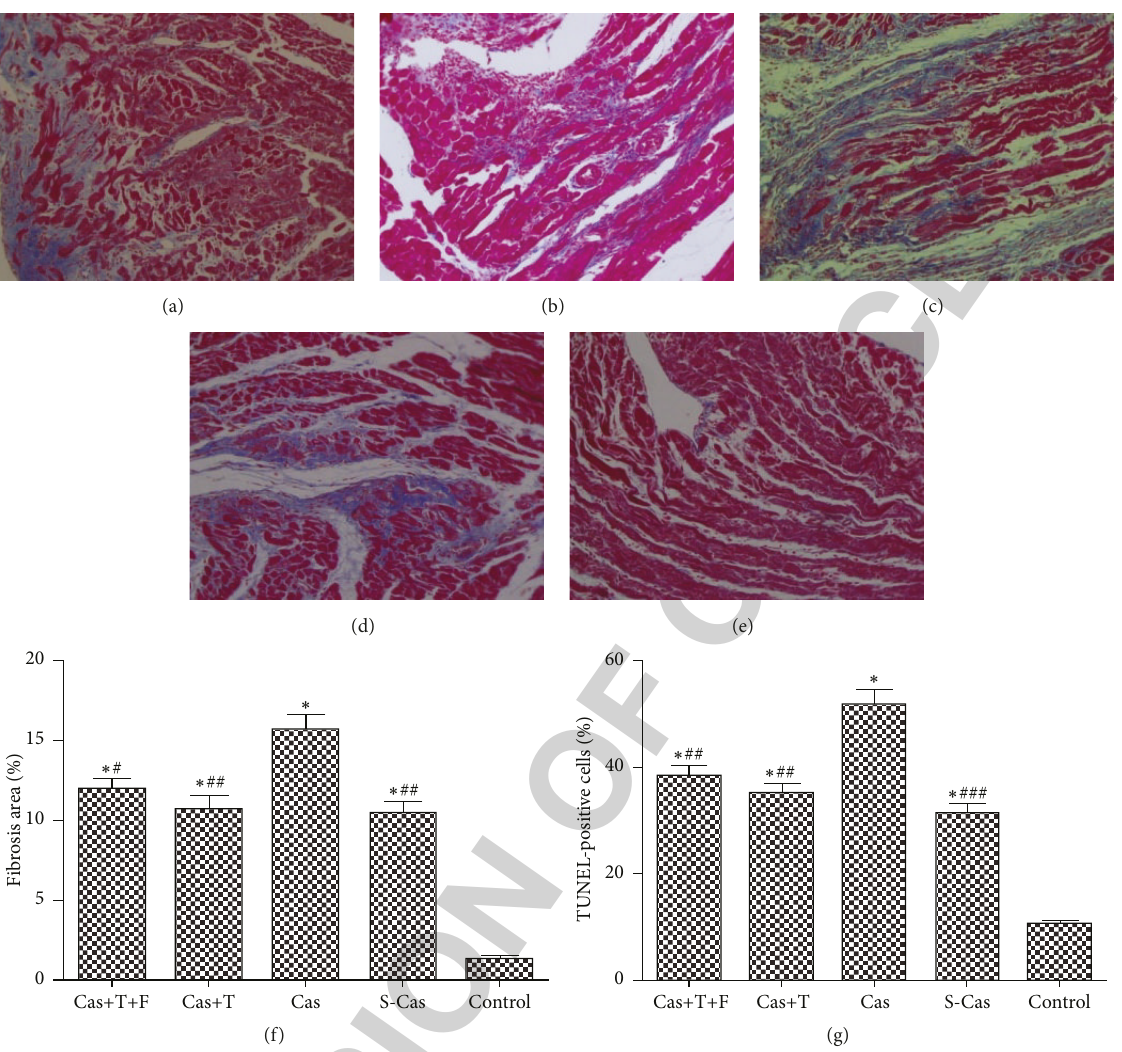
Figure 8: Effects of castration and testosterone replacement on myocardial fibrosis and apoptosis. Representative magnification (200x) of Masson-Trichrome sections of the heart. (a) Cas+T+F group, (b) Cas+T group, (c) Cas group, (d) S-Cas group, (e) control group, and (f) quantitative analysis of fibrotic area. (g) The TUNEL-positive cells percent expressed as a percent of normal nuclei. Values are means ± SD; 𝑛 = 3 . S-Cas: sham-castration; Cas: castration; T: testosterone; F: flutamide. ∗ 𝑃 < 0.001 versus control group; # 𝑃 < 0.05 , ## 𝑃 < 0.01 , and ### 𝑃 < 0.001 versus